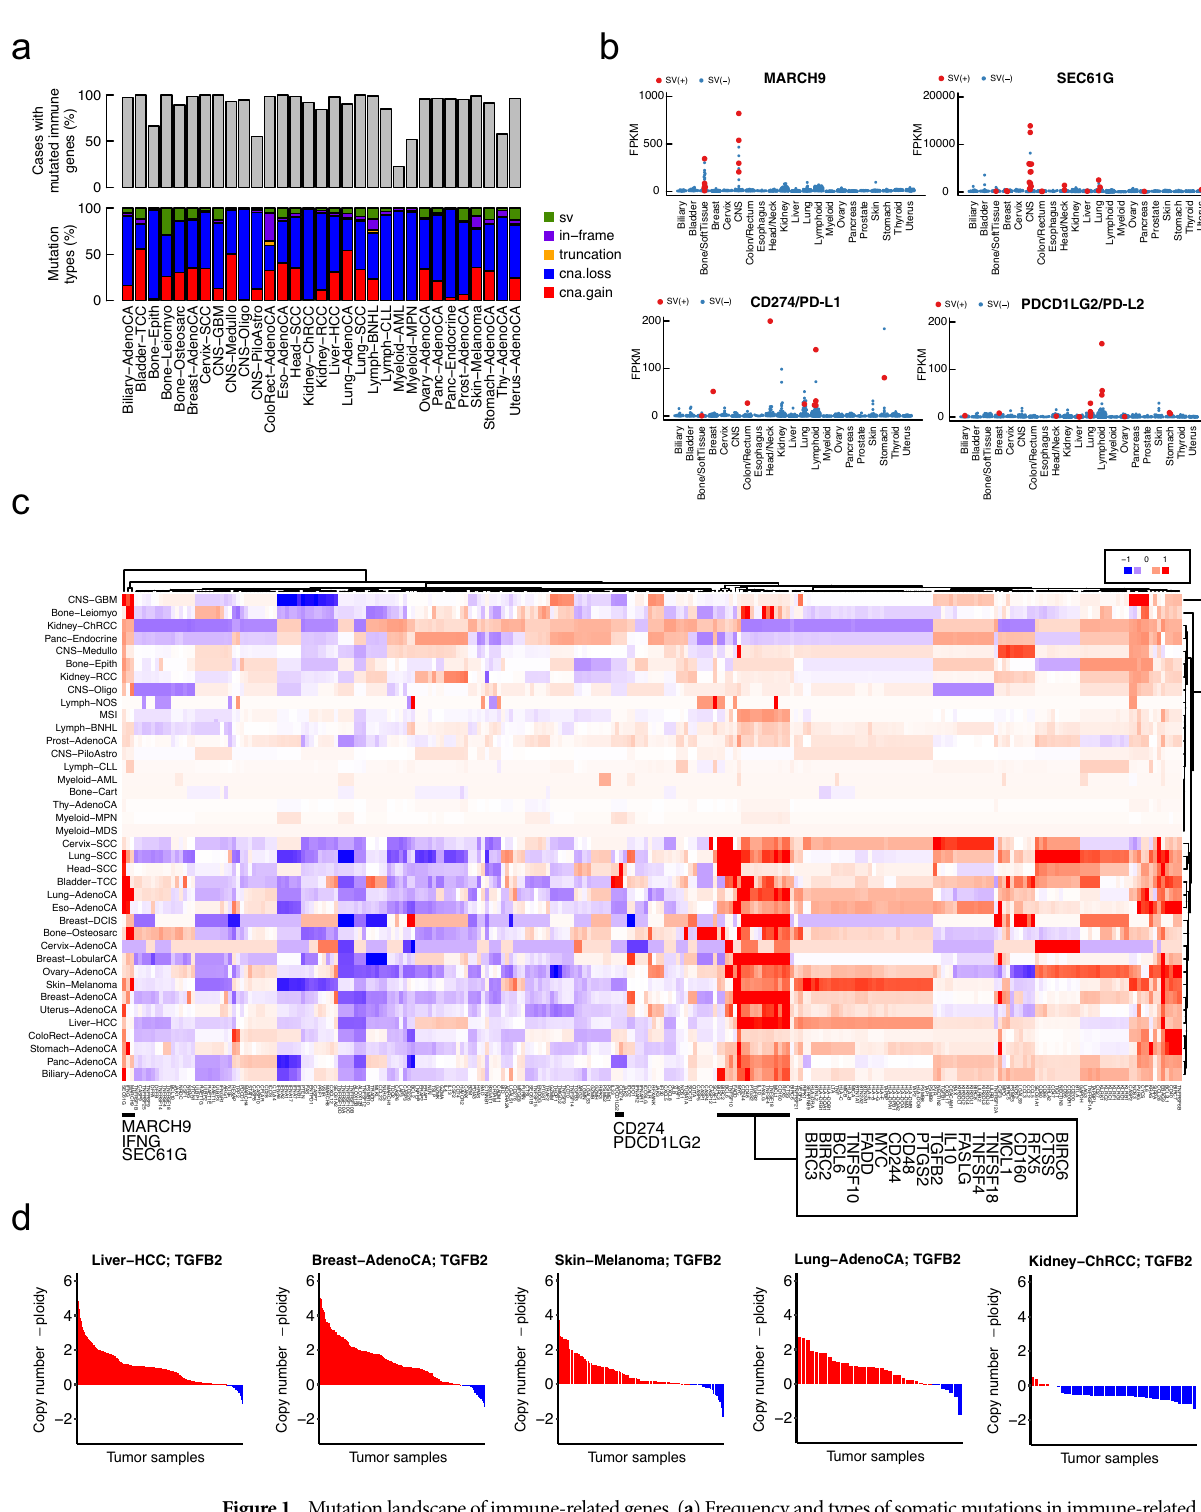
Figure 1. Mutation landscape of immune-related genes. ( a ) Frequency and types of somatic mutations in immune-related genes. Single nucleotide variants (SNVs), insertions and deletions (indels), structural variants (SVs), and copy number alterations (CNAs) were examined in immune-related genes and donors for multiple types of tumors, where “truncation” represents “stop gain SNV” and “frameshift indel,” and “in-frame” in frame “nonsynonymous SNV” and “in-frame indel.” ( b ) The overexpression of immune-related genes and its association with SVs in each tumor type. Red and blue dots indicate tumor samples with and without SVs, respectively. ( c ) Copy number of IL10 offset by tumor ploidy. Tumor samples are colored red and blue to indicate whether the copy number is above or below the ploidy level, respectively. The heatmap was generated by the R software (R 3.4.0 (April, 2017) 24 ). ( d ) Selective copy number changes of immune-related genes in each tumor type. Red and blue represent an excess or deficiency in the gene copy number, respectively, compared to the tumor ploidy level. The color of the element represents the mean value of the differences between copy number and